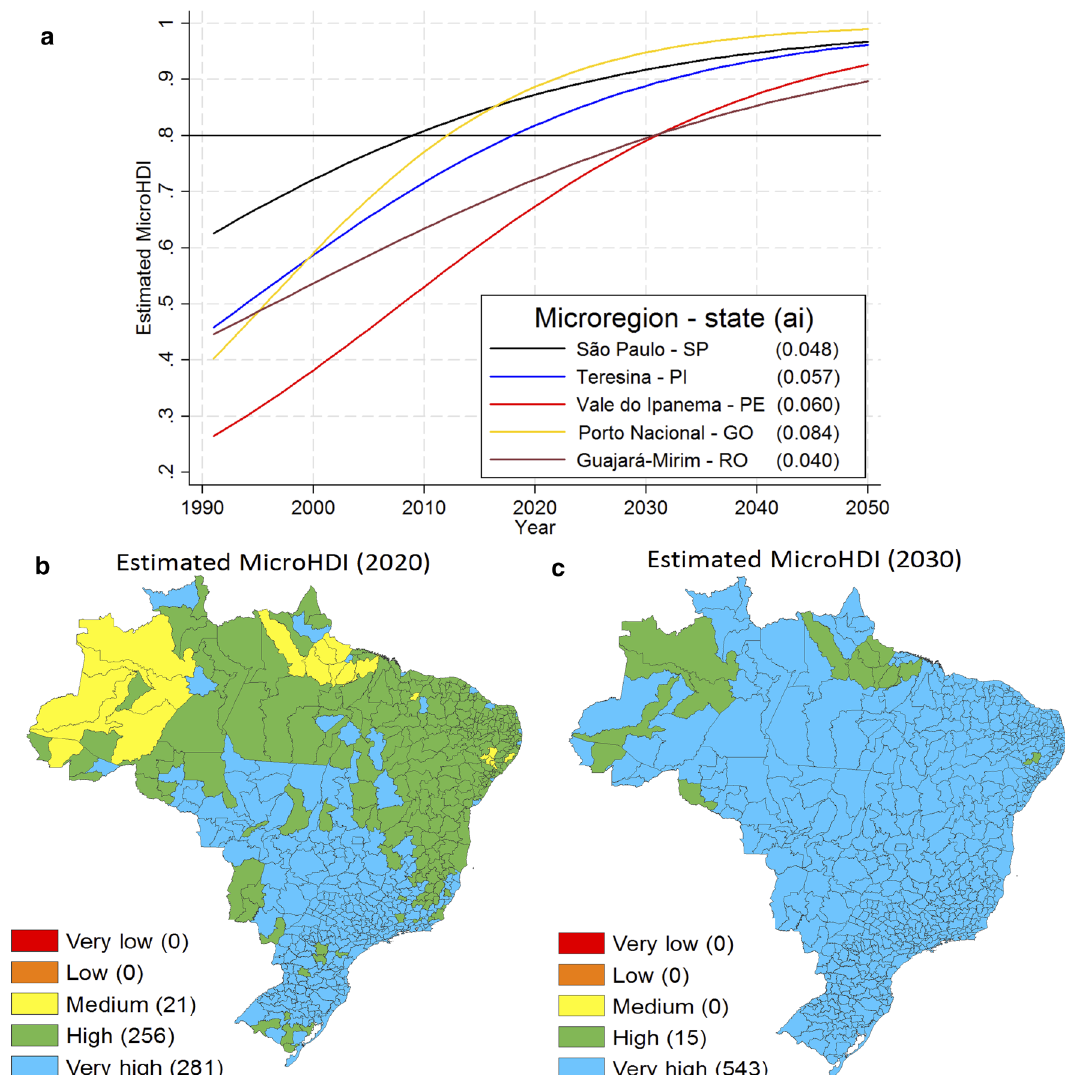
Fig. 3 Projected MicroHDI for Brazil. Projected MicroHDI in a temporal perspective for some contrasting microregions ( a ). The horizontal line represents the MicroHDI value of 0.8, representative of a very high development standard, whereas a fast a microregion develops. MicroHDI projected values from Eq. 2, 2020 ( b ). MicroHDI projected values from Eq. 2, 2030 ( c